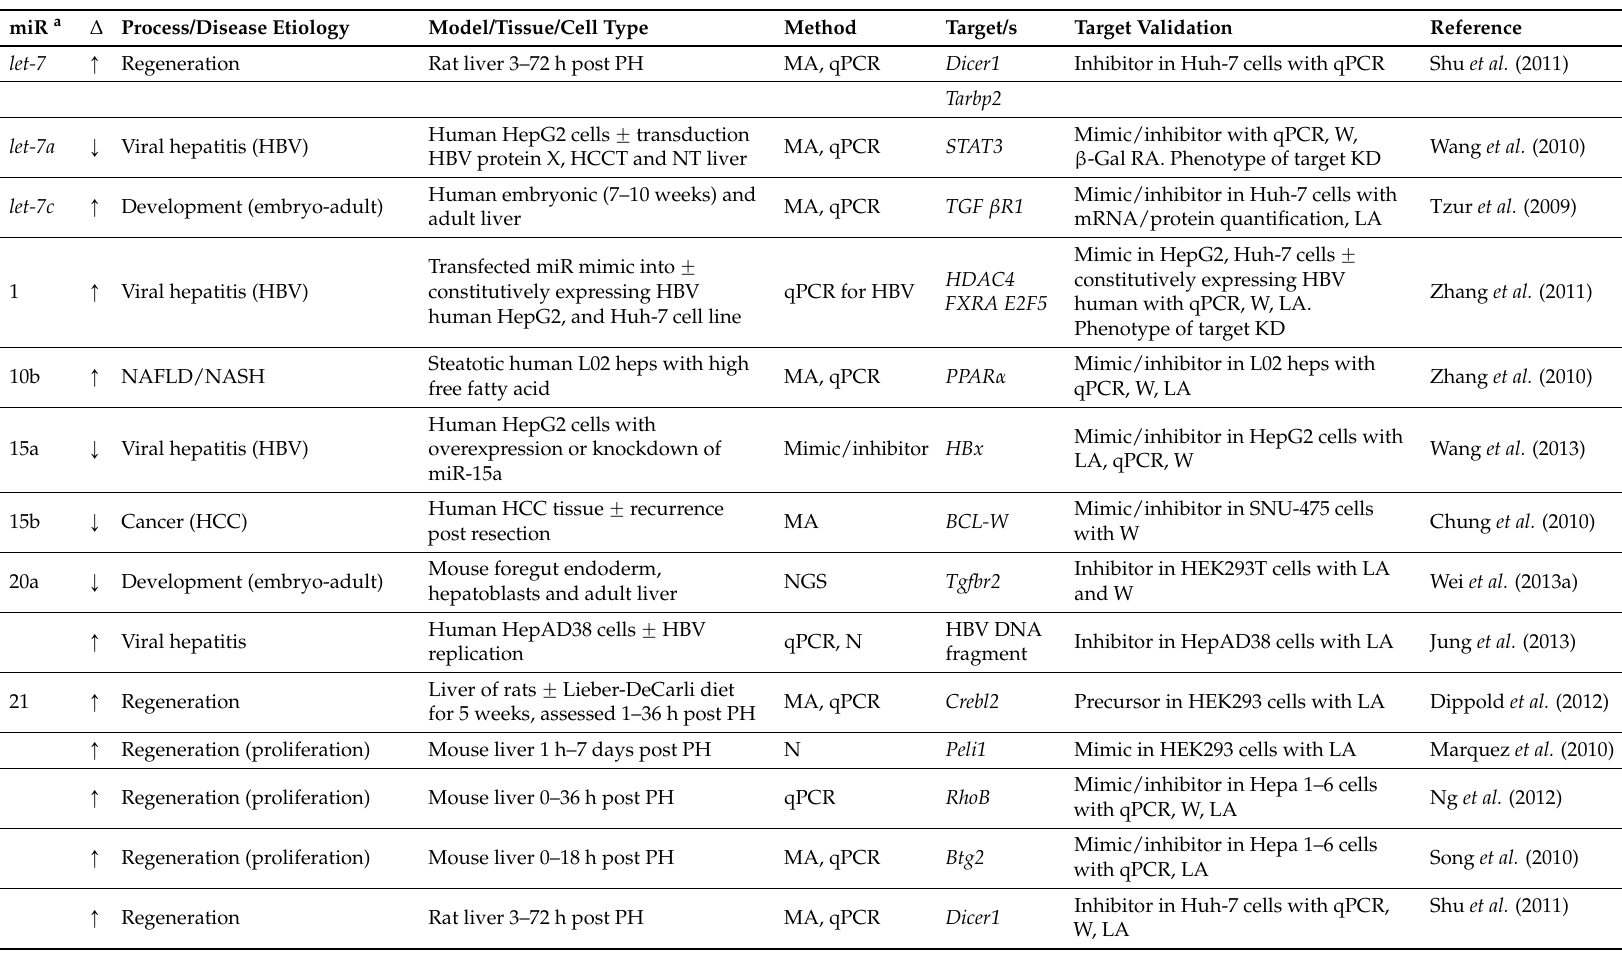
Table 1. Changes in microRNA abundance and validated target genes during liver development, regeneration and disease. Reprinted with permission from “Regulation of microRNAs and Their Role in Liver Development, Regeneration and Disease” ( Int. J. Biochem. Cell. Biol. 2014